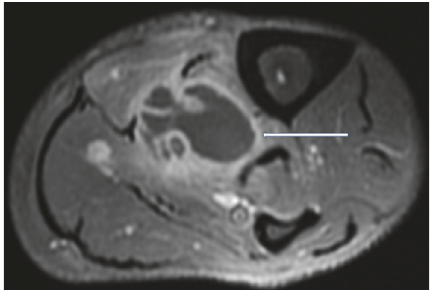
Figure 4: T2 weighted, fat saturated, postcontrast, axial MR image of left calf at another location, again showing a multiloculated fluid collection with associated enhancing rim and septations (white arrows) within the tibialis posterior muscle, compatible with an intramuscular